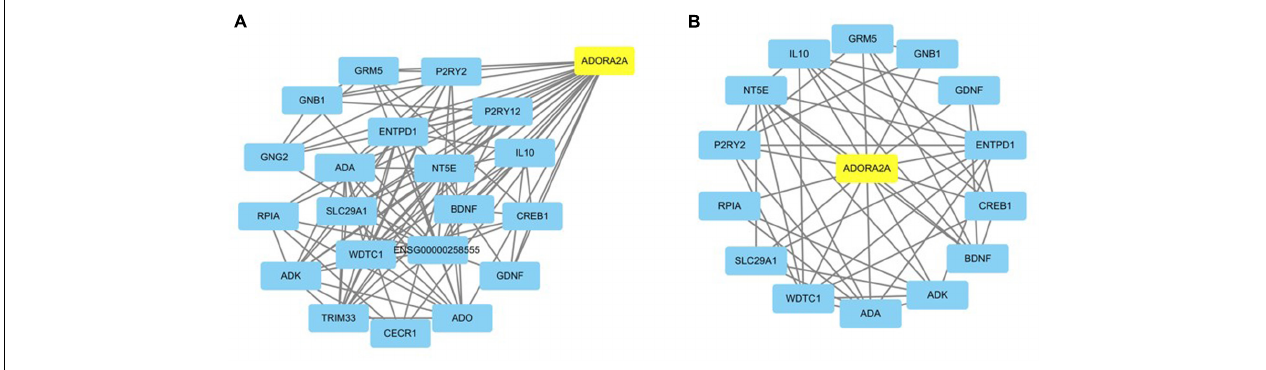
FIGURE 1 | Protein–protein interaction (PPI) network analysis of ADORA2A. (A) The PPI network of ADORA2A comprised 21 nodes and 103 edges. (B) The PPI network between ADORA2A and 14 common genes associated with epilepsy comprised 15 nodes and 50 edges. Each target protein was represented by a